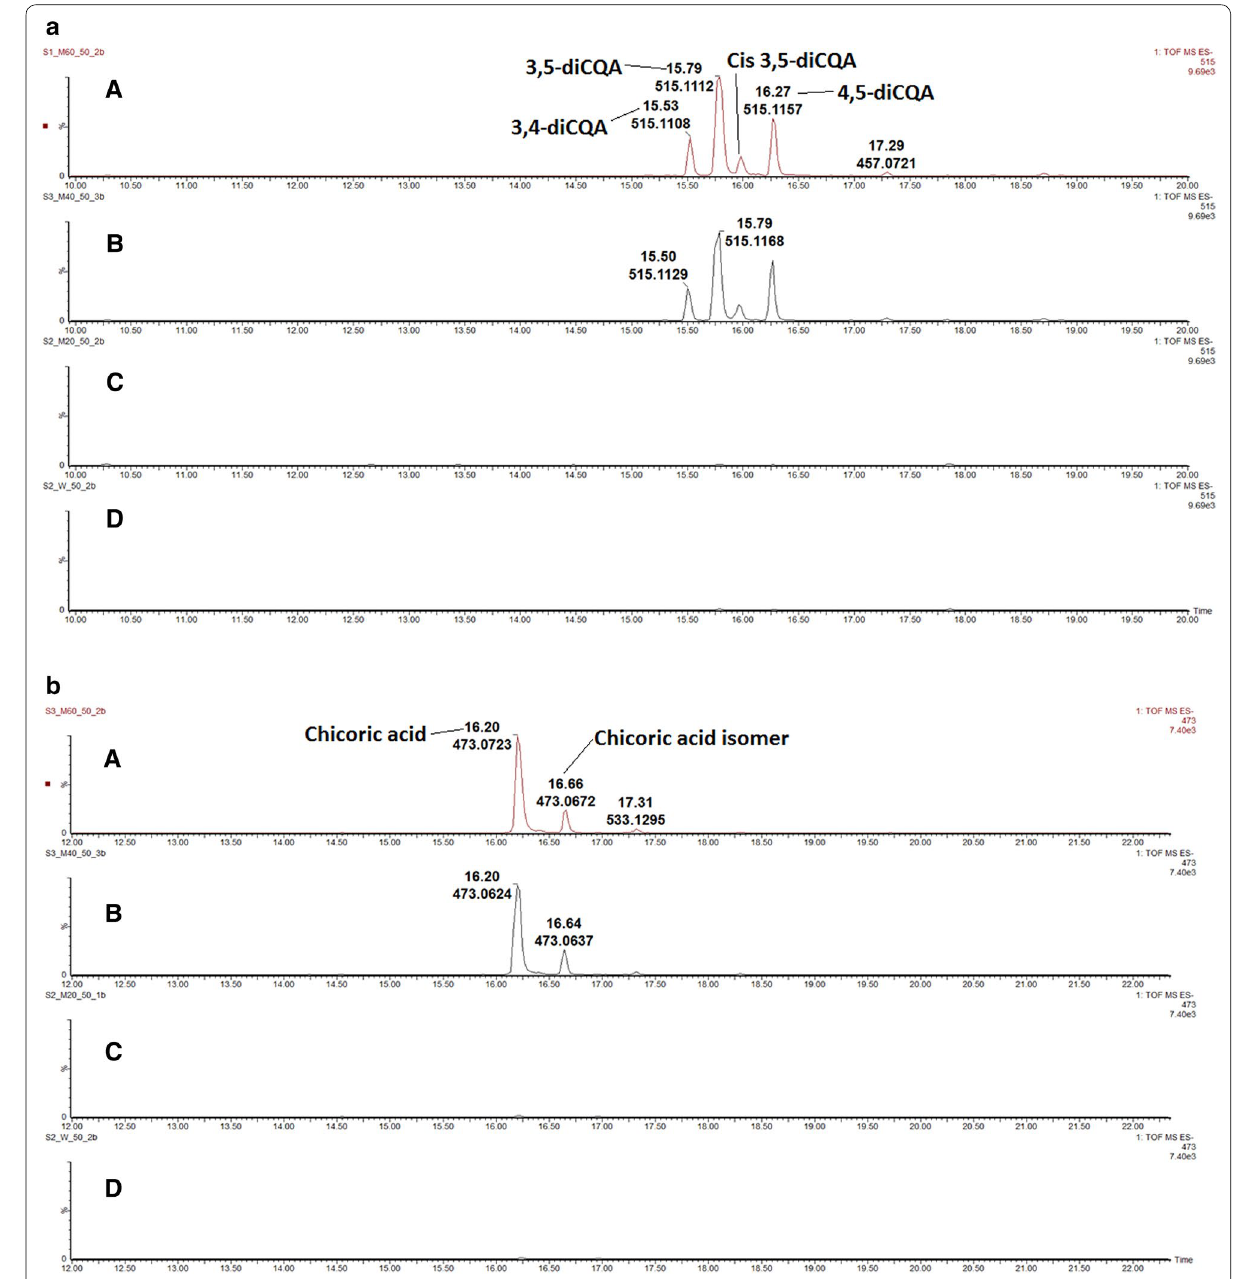
Fig. 4 a Representative UPLC-MS single ion monitoring (SIM) chromatograms for isomers of diCQA following PHWE of B. pilosa at 50 °C using 60 % MeOH ( A ), 40 % MeOH ( B ), 20 % MeOH ( C ) and 0 % MeOH (water) ( D ). b Representative UPLC-MS single ion monitoring (SIM) chromatograms